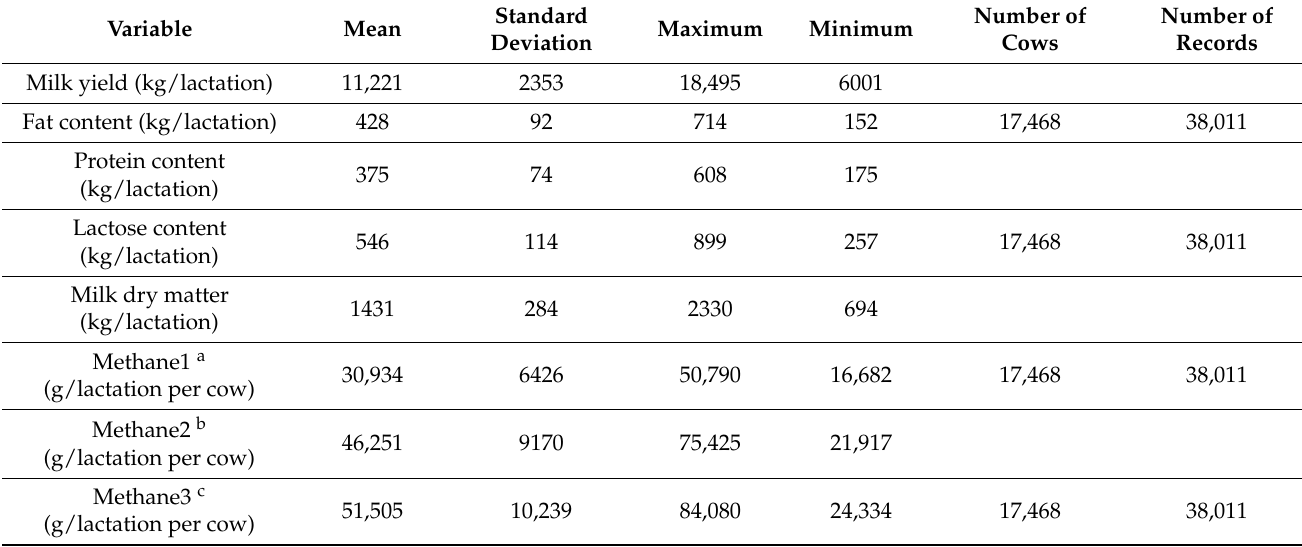
Table 1. Summary statistics of the analysed data.